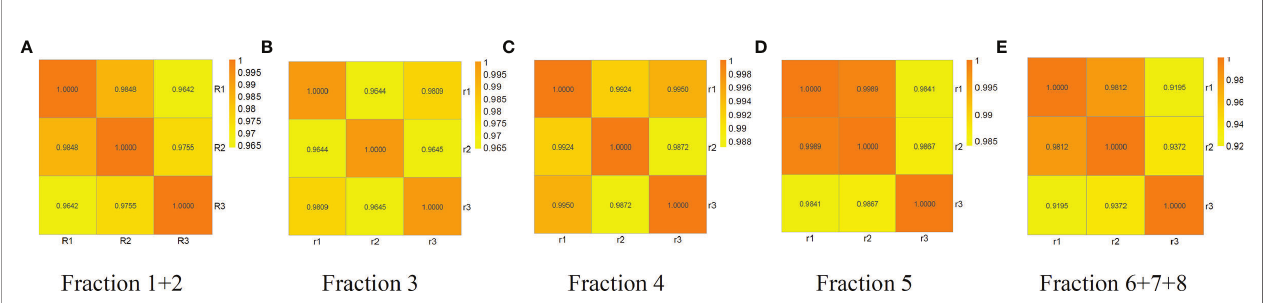
FIGURE 3 | Reproducibility analysis of three independent replicates of fraction 1 + 2, 3, 4, 5 and 6 + 7+8 from a random serum sample. Pearson correlation coef fi cient R 2 values for the binary comparison of the three replicates range from 0.9195 to 0.9989, demonstrating good reproducibility of the method. (A) fraction1+2, (B) fraction 3, (C) fraction 4, (D) fraction 5, and (E) fraction 6 +